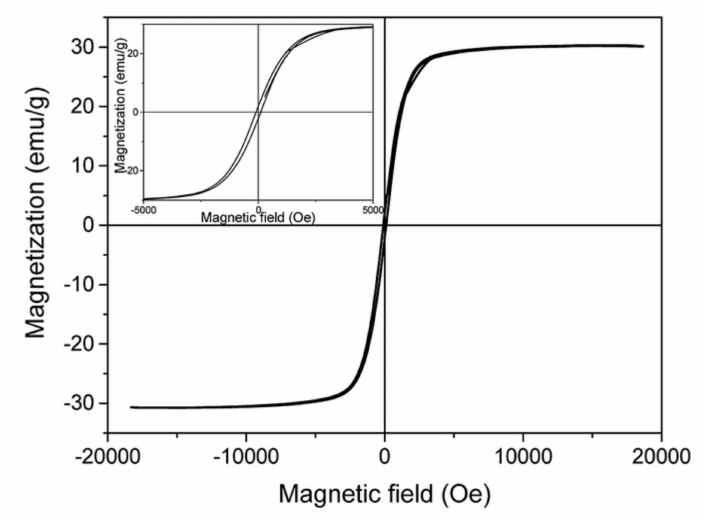
Figure 10. Magnetic hysteresis loop of magnetic activated carbon obtained by FeCl 3 chemical activation (reprinted from [60] with the permission of the RSC,